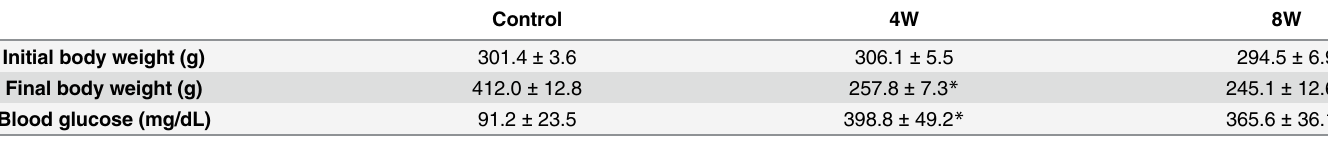
Table 1. Animal evolution: Analysis of initial and final body weight, and blood glucose levels 72 h. after treatment inoculation in four (4W) and eight (8W) weeks ’ diabetic rats.